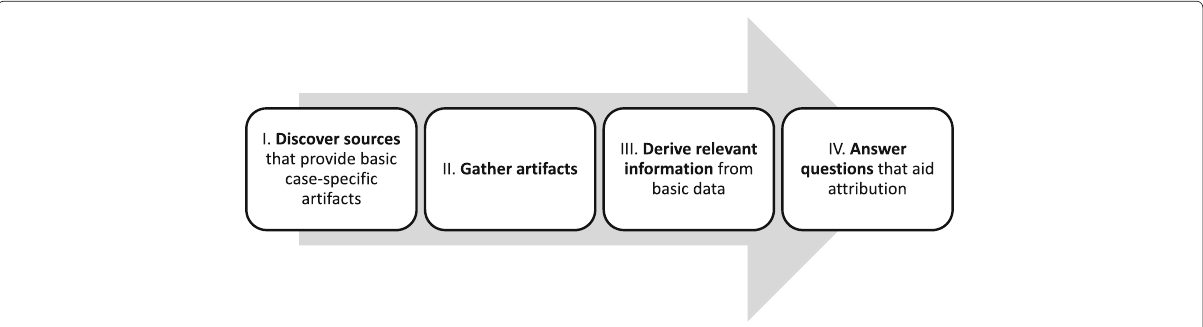
Fig. 3 A simplified linear view on the attribution